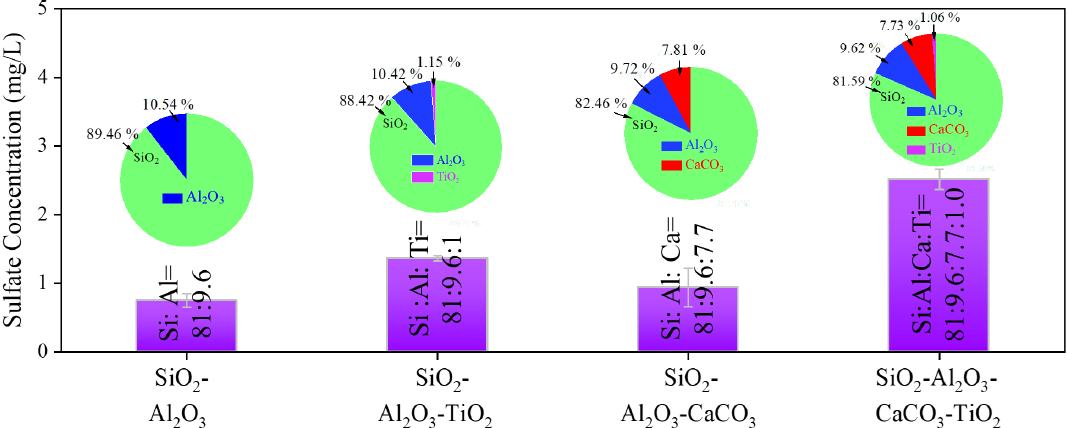
Figure 4. Sulfate concentration quantified by IC. Sulfate concentration was measured by IC on mineral dust simulants after exposure to gaseous SO 2 (2.46 × 10 14 molec.cm − 3 ) under irradiation. Noting that SiO 2 :Al 2 O 3 :CaCO 3 :TiO 2 refers to the mass fraction ratios of the components in simulants. Experiments were all conducted at an RH of 30% and light intensity ( I ) of 30mWcm − 2